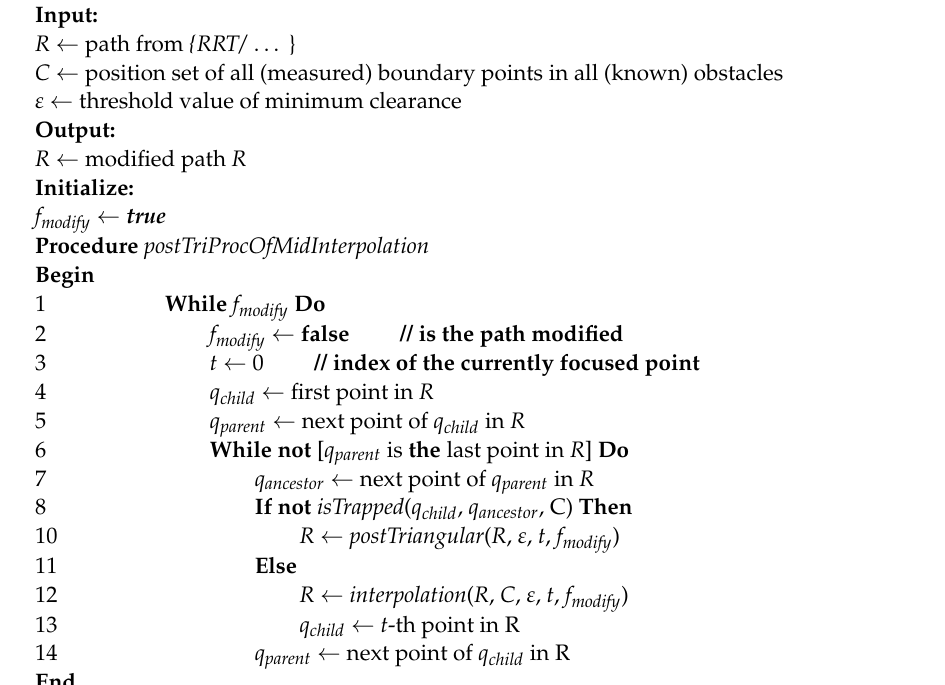
Algorithm 3 Pseudocode of Proposed Post Triangular Processing of Midpoint Interpolation